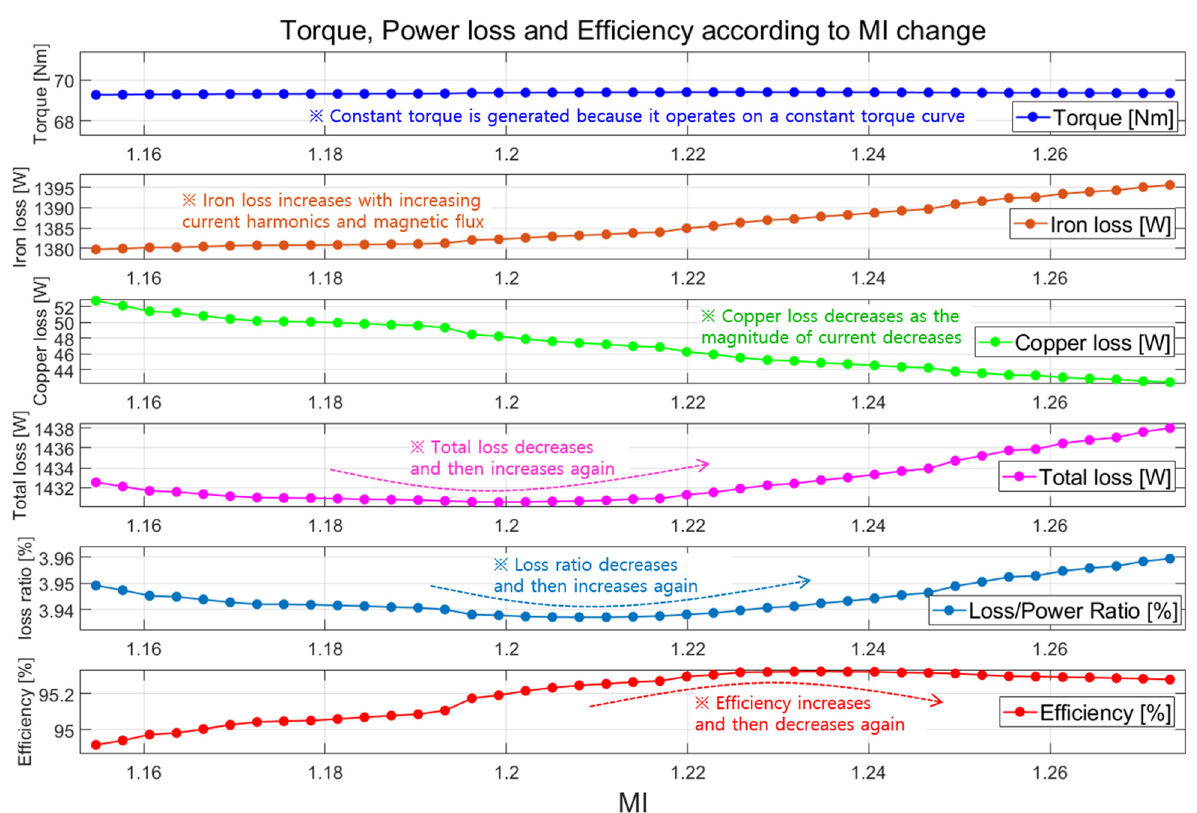
Figure 9. Test point for observing the efficiency change on a constant torque curve.